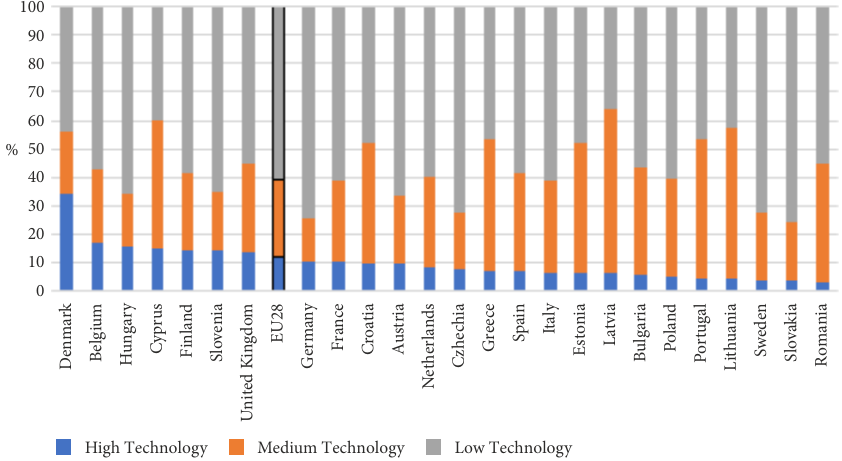
Figure 2. The manufacturing industry structure based on GVA by technological intensity, 2018